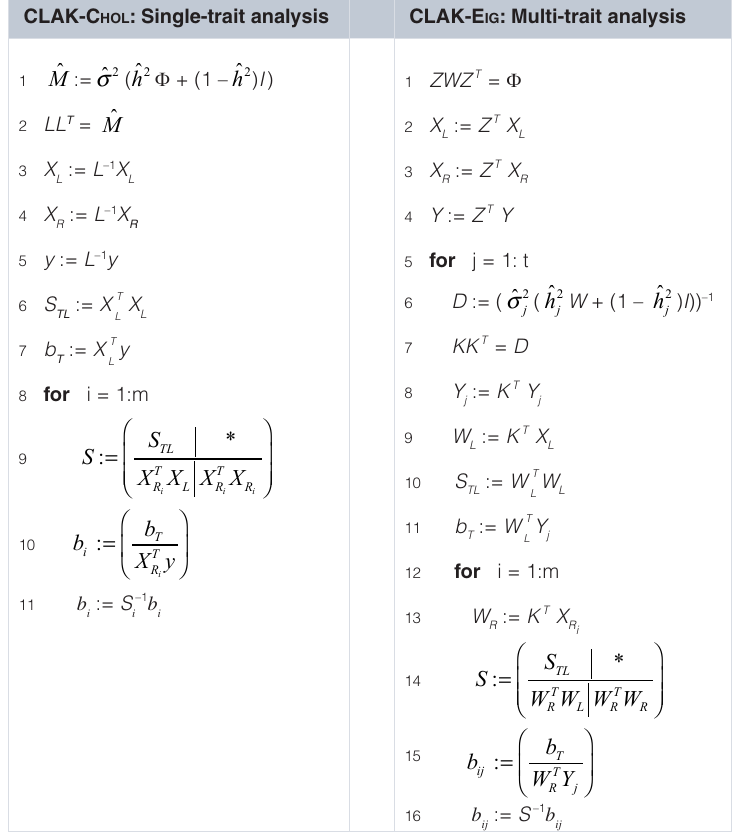
Table S1. The CLAK-C hol and CLAK-E ig algorithms for single-trait and multi- trait analyses, respectively. CLAK-C hol : Single-trait analysis CLAK-E ig : Multi-trait